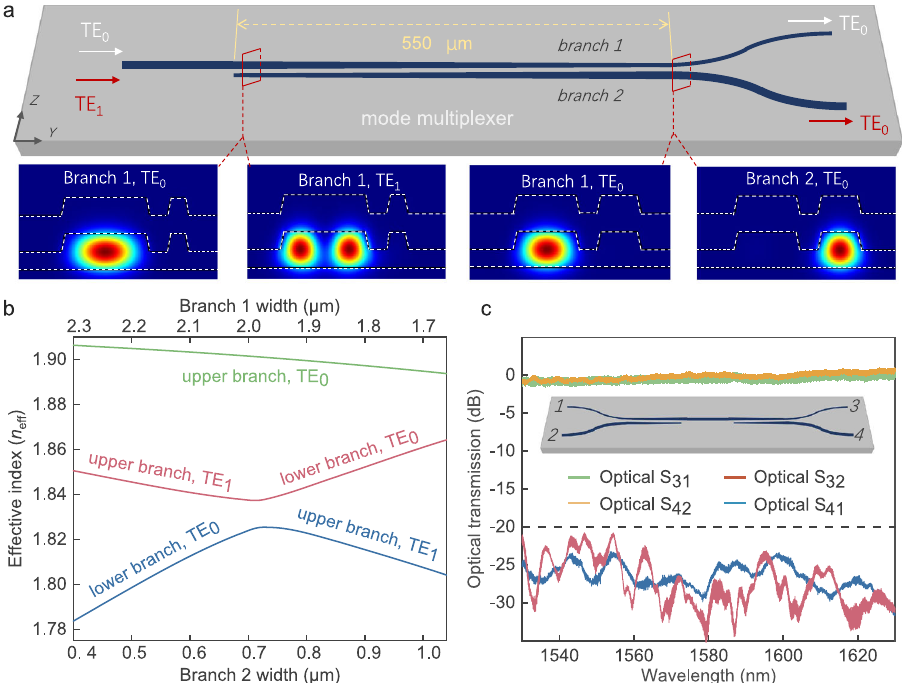
Fig. 2 Design and characterization of the broadband adiabatic mode multiplexer. a Device schematic, where input TE 0 and TE 1 modes are demultiplexed into TE 0 modes in the upper and lower output branches respectively (TE 0 : fundamental transverse-electric mode, TE 1 : second-order transverse-electric mode). Insets show the corresponding simulated eigenmode pro fi les of the coupled-waveguide system at different locations. b Effective index ( n eff ) evolution for the three lowest-order modes along our adiabatic mode multiplexer, at a wavelength of 1550 nm. c Measured optical transmission ( S 31 and S S S 42 ) and crosstalk ( 32 and 41 ) of a 2 × 2 cascaded multiplexer structure (inset), showing low optical losses of <0.4 dB and high extinction ratios of > 20 dB from 1530 nm to 1630